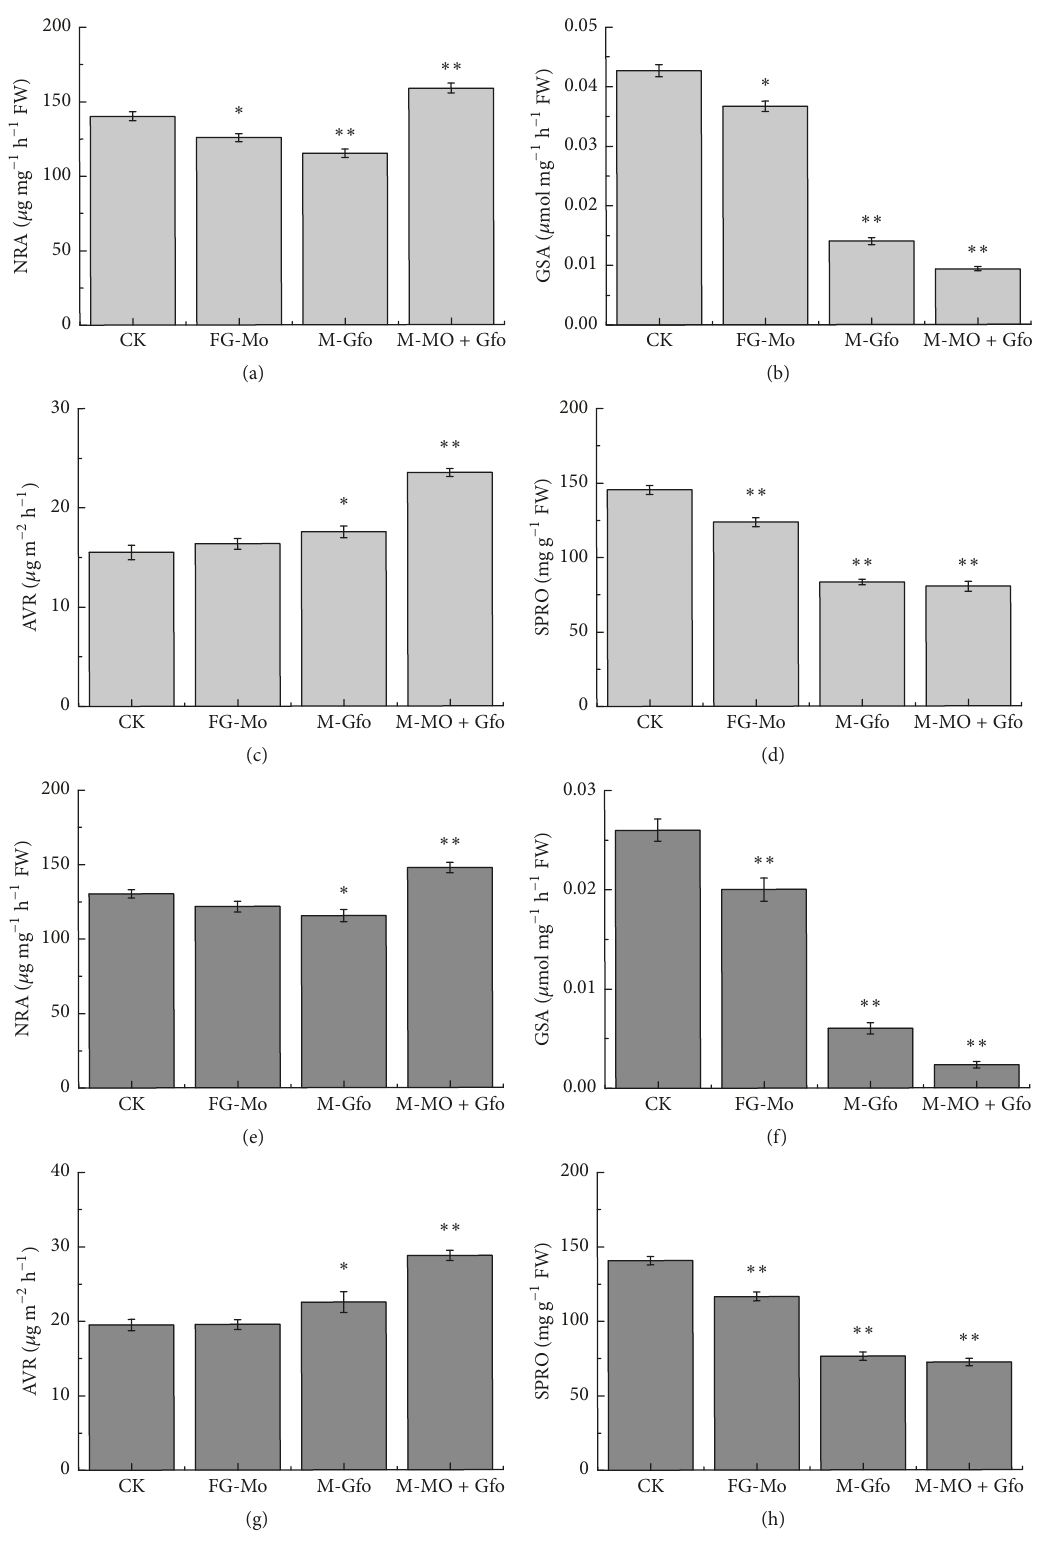
Figure 3: Effects of Mo and Gfo treatments on NRA, AVR, GSA, and SPRO in burley tobacco. Error bars represent standard error ( 𝑛 = 3 ). NRA: nitrate reductase activity; AVR: ammonia volatilization rate; GSA: glutamine synthetase activity; SPRO: total soluble protein content. (a–d) KT204. (e–h) TN86. Symbols ∗∗ and ∗ indicate significant difference at 0.01 or 0.05,